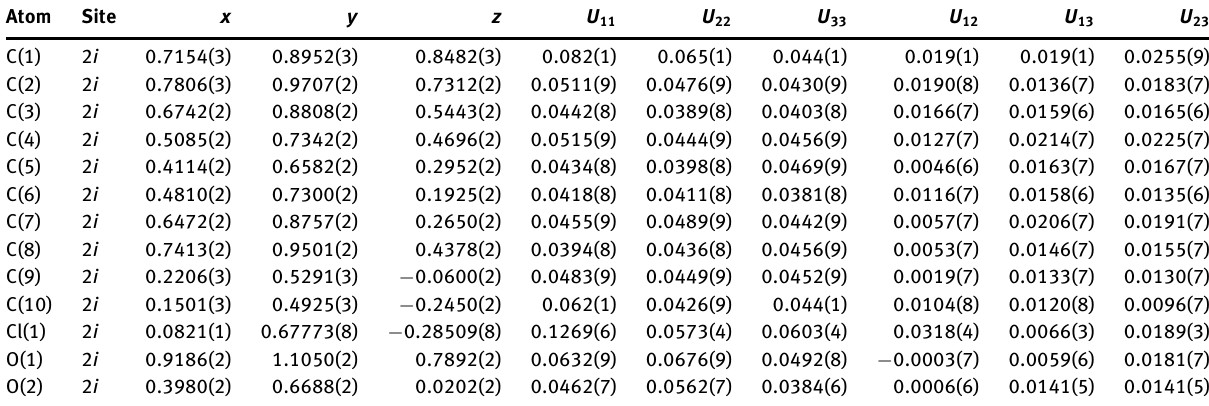
Table 3: Atomic displacement parameters (Å 2